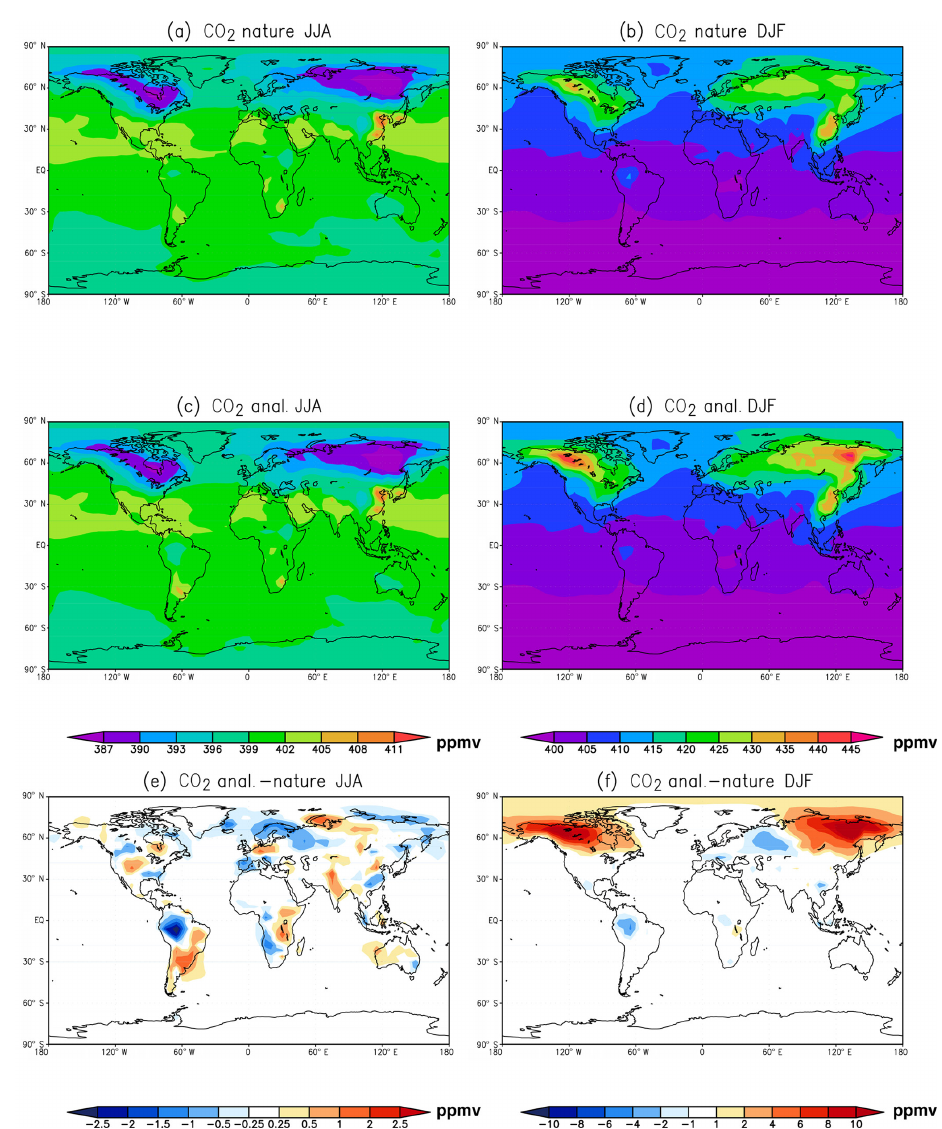
Figure 7. Same as Fig. 6, except for surface concentrations of CO 2 . Where panels (a) and (c) share the upper left color bar; Panels (b) and (d) use the upper right color